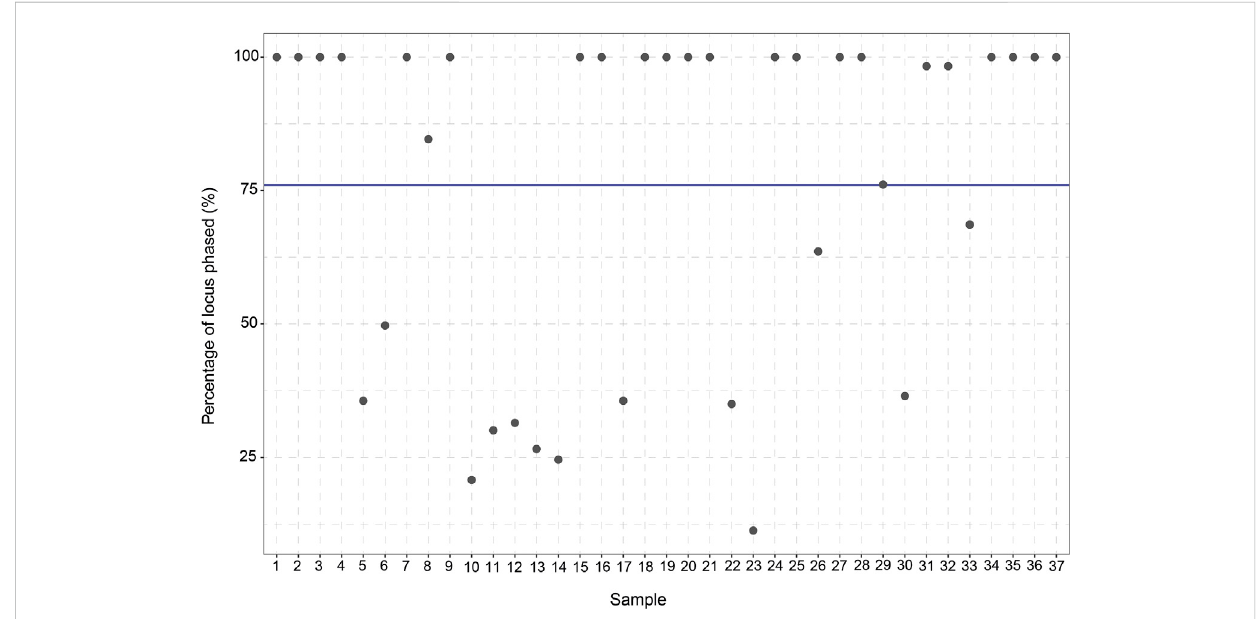
FIGURE 3 Percentage of CYP2C19 variants phased to their allele of origin per sample. For every sample ( n = 37) the percentage (%) of the variants which could be phased to their allele of origin was calculated. The blue line displays the average percentage of phased variants for the 37 samples